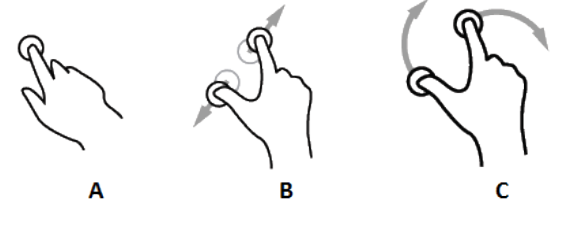
Figure 9. Selection/Manipulation gestures. (a) Tap (b) Scale (c) Rotation